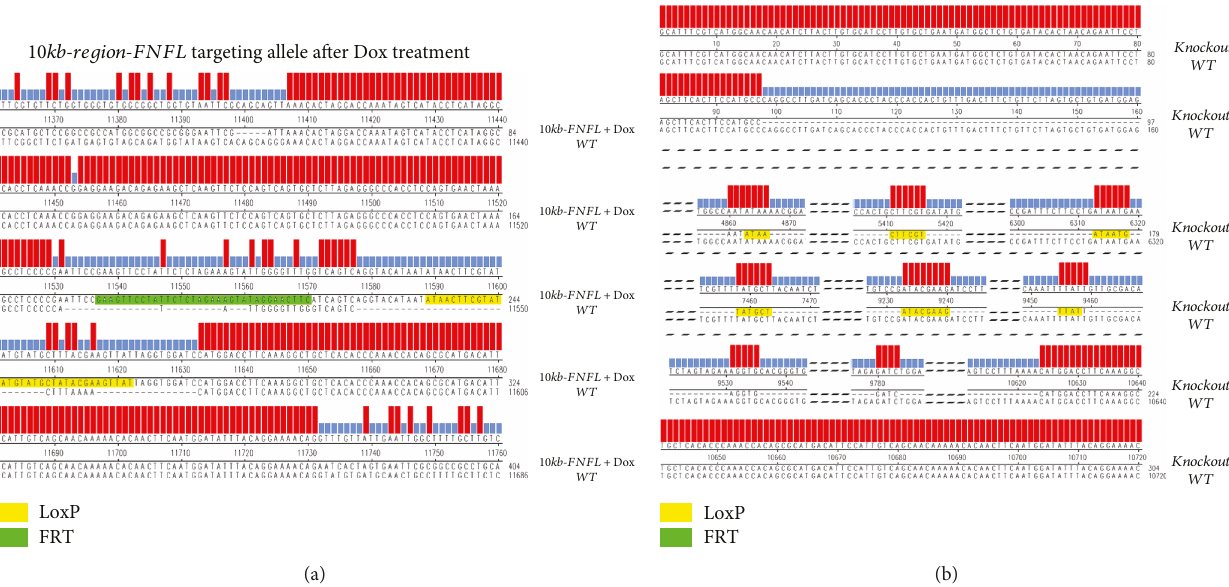
Figure 6: Sequencing results of the conditional knockout allele of the 10 kb putative regulatory region. (a) Sequence of the FNFL targeting locus after Dox treatment. When FLP was induced by Dox, part of the FNFL cassette was deleted with one LoxP site and one FRT site left. The LoxP site and FRT site are indicated in yellow and green, respectively. (b) Sequence of the conditional knockout allele of the 10 kb regulatory region generated by 4-OHT treatment. The sequence alignment was analyzed by DNASTAR